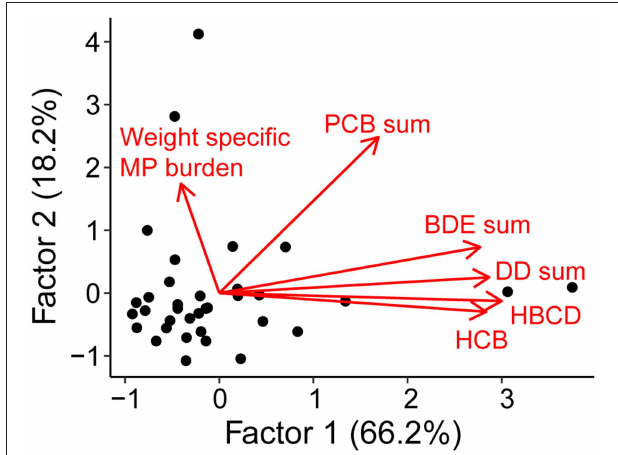
FIGURE 4 | Factor scores (axes) and loadings (arrows) of contaminants (HBCD, HCB and the sum of PCBs, BDEs, and DDs) and weight-specific MP burden. The data included in this analysis were weighted MP burden and HOC concentrations in herring muscle tissue determined in (1) individual fish specimens, and (2) pooled fish samples (10 ind. per